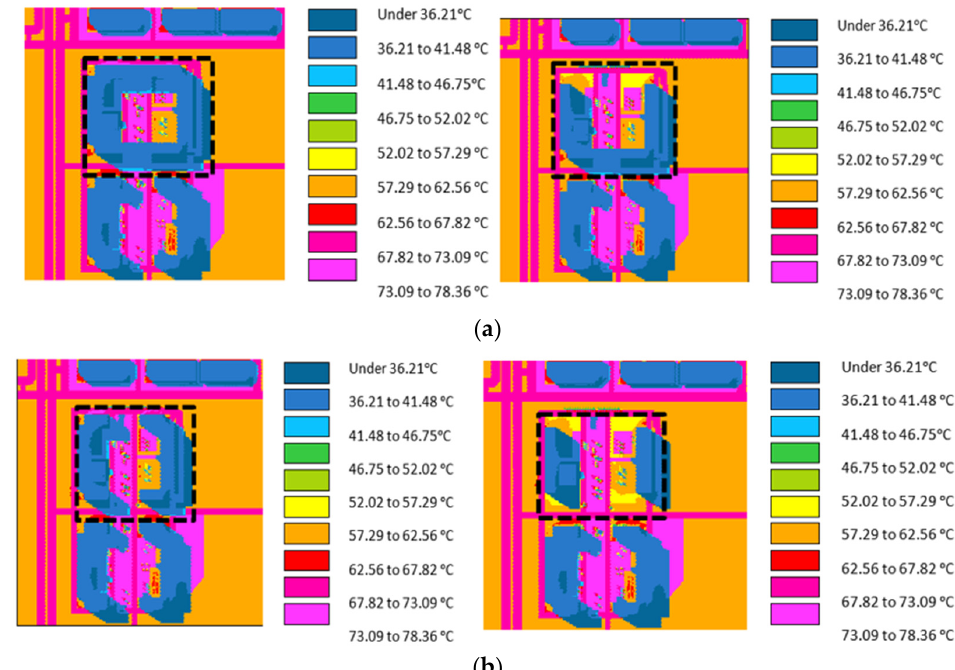
Figure 16. ( a ) Predicted mean radiant temperature bands at 0 m above the ground level at 4 p.m. in the FBTS models (Left—courtyard; Right—U model). ( b ) Predicted mean radiant temperature bands at 0 m above the ground level at 4 p.m. in the FBTS models (Left—courtyard canyon; Right—canyon).